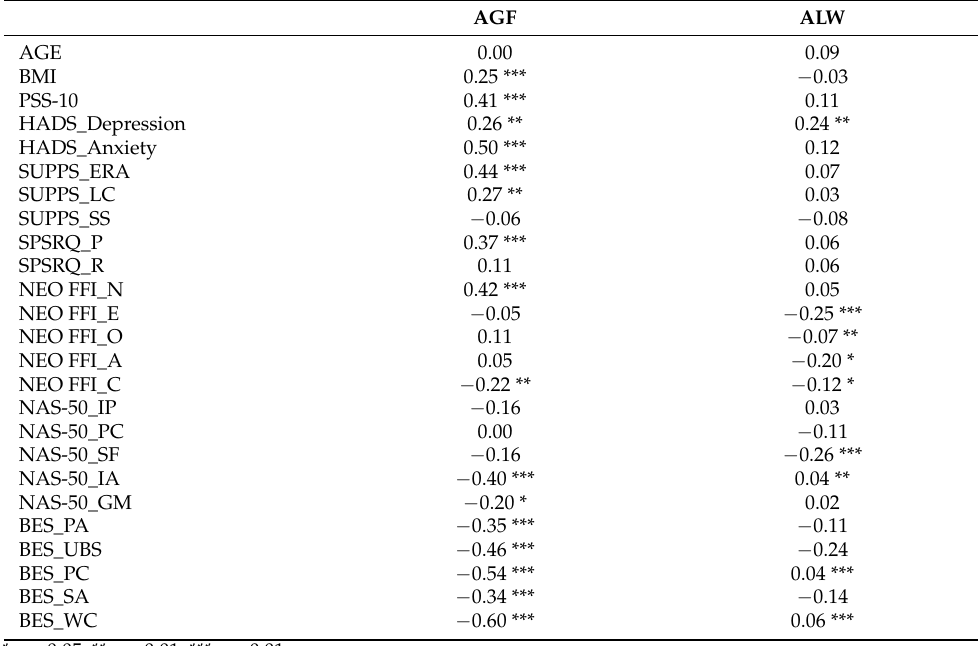
Table 5. Correlation of BMAS scale factors with other